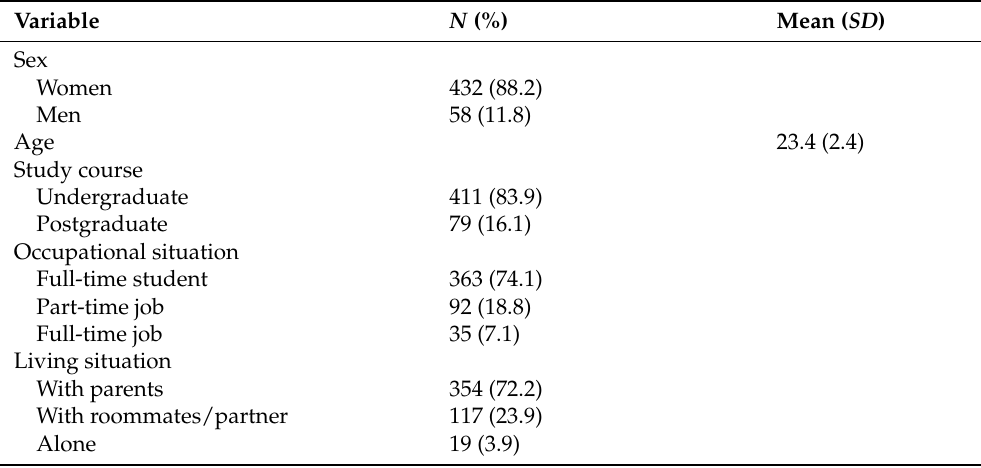
Table 1. Participants’ ( n = 490) socio-demographic, health-related, and sleep